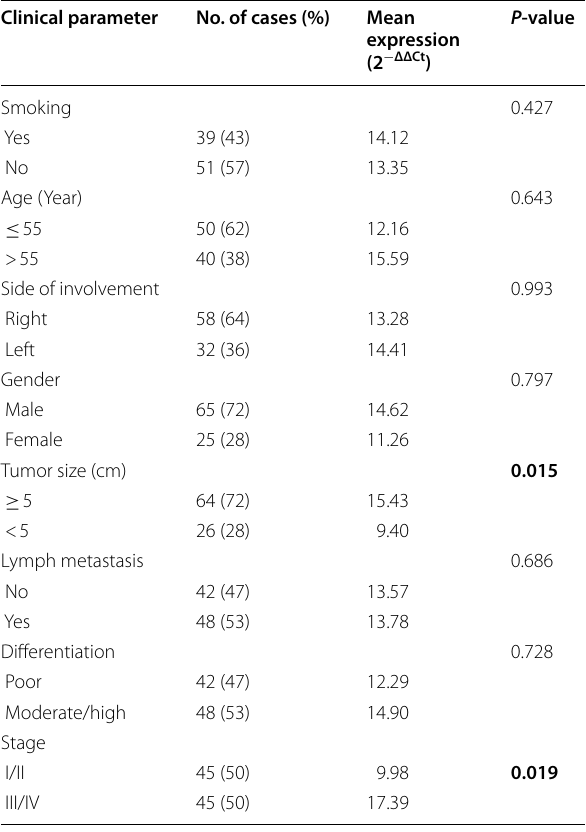
Table 1 Association between lncRNA AFAP1-AS1 expression